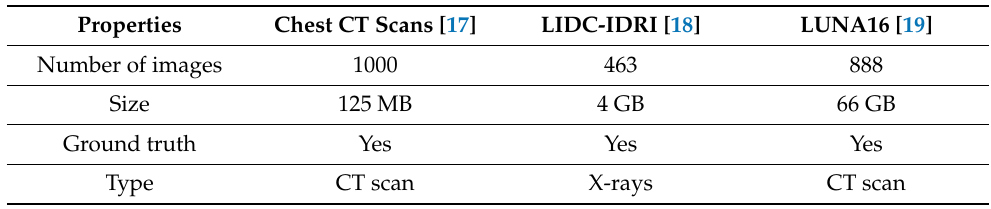
Table 1. The utilized datasets.